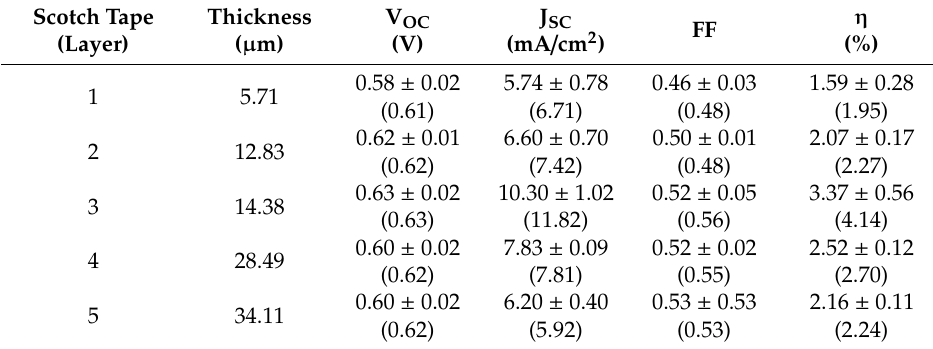
Table 1. Photovoltaic parameter of dye-sensitized solar cells (DSSC) with di ff erent TiO 2 film thickness including average data with standard deviation were based on five devices. The best performing devices data are given in